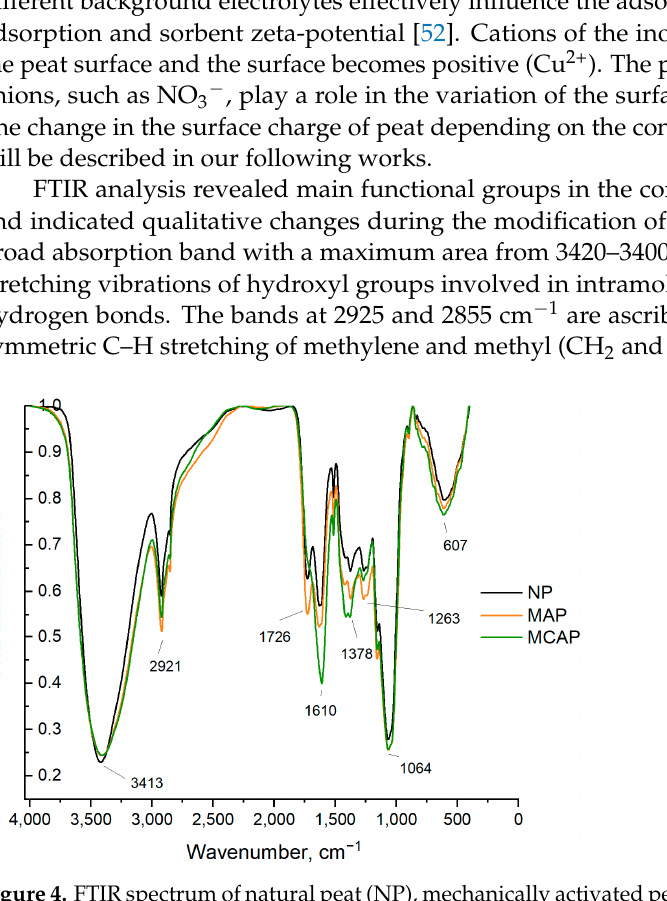
Figure 4. FTIR spectrum of natural peat (NP), mechanically activated peat (MAP), mechanochemically activated peat (MCAP).